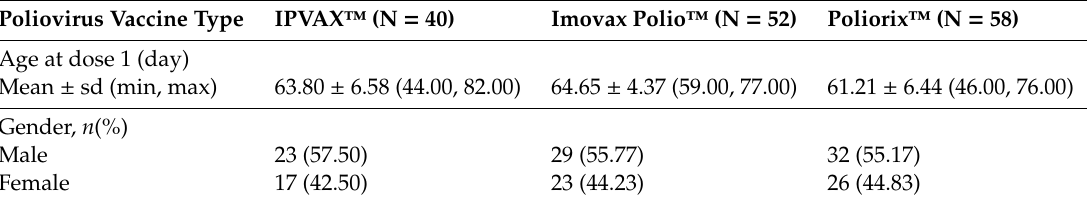
Table 1. Demographic characteristics.